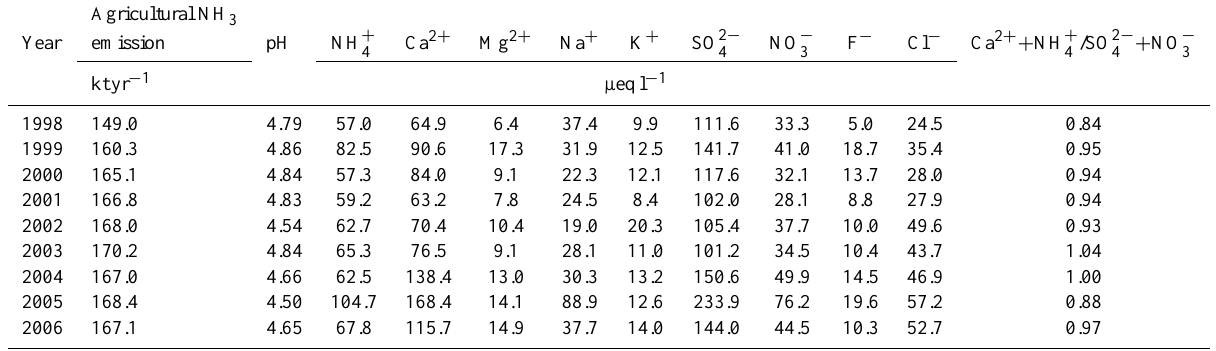
Table 7. Agricultural NH 3 emission and chemical compositions of precipitation in the PRD region, 1986–2006. Agricultural NH